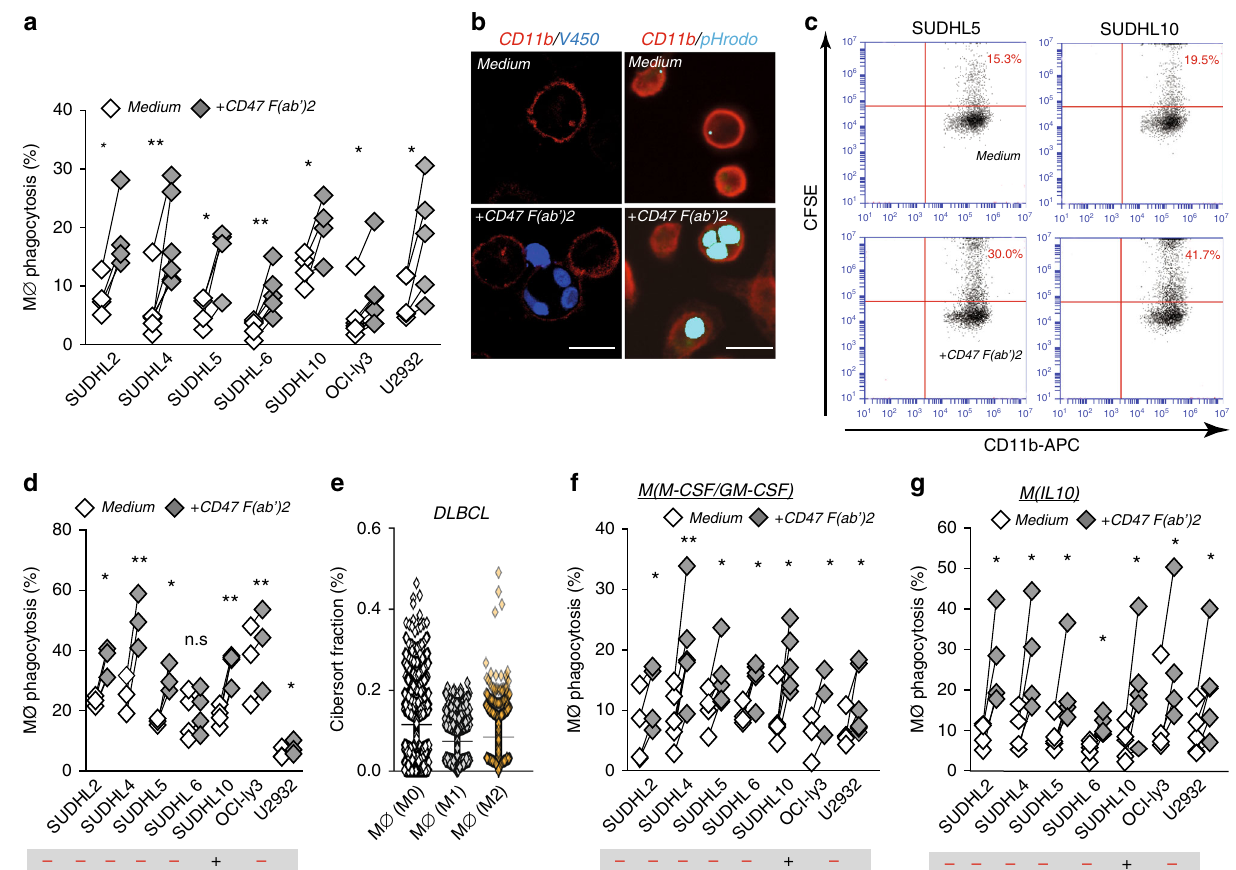
Fig. 2 Tumor-expressing SLAMF7 is not required for induction of phagocytosis upon CD47-targeting treatment in DLBCL cells. a Percentage of phagocytosis of DLBCL cell lines by allogeneic human macrophages primed with LPS/IFN- γ upon 3 h treatment with F(ab ′ )2 of anti-CD47 antibody inhibrix (CD47 F(ab ′ )2) vs. untreated cells ( n = 3 – 5). b Representative microscopy pictures of phagocytosis of tumor cells by macrophages primed with LPS/IFN- γ upon 3 h treatment with CD47 F(ab ′ )2 (left, MØ + V450-labeled OCIly3 cells, right, MØ + pHrodogreen-labeled SUDHL5 cells). Scale bar = 20 µ m. c Representative graphs of fl ow cytometric analysis for phagocytosis of tumor cells by macrophages with LPS/IFN- γ upon 3 h treatment with CD47 F(ab ′ )2 (left, MØ + SUDHL5, right, MØ + SUDHL10). d Quanti fi cation of phagocytosis of DLBCL cell lines by fl ow cytometric analysis. Experimental setting is the same as in ( a ) ( n = 3 – 4). e Percentage of different types of macrophages from cibersort fraction of DLBCL biopsies ( n = 1804). f Percentage of phagocytosis of DLBCL cell lines by allogeneic type 0 human macrophages upon 3 h treatment with F(ab ′ )2 of anti-CD47 antibody inhibrix (CD47 F(ab ′ )2) vs. untreated cells ( n = 4 – 6). g Percentage of phagocytosis of DLBCL cell lines by allogeneic human macrophages primed with IL-10 upon 3 h treatment with F(ab ′ )2 of anti-CD47 antibody inhibrix (CD47 F(ab ′ )2) vs. untreated cells ( n = 4 – 6). Statistics was performed using paired Student ’ s t -test. n.s. =